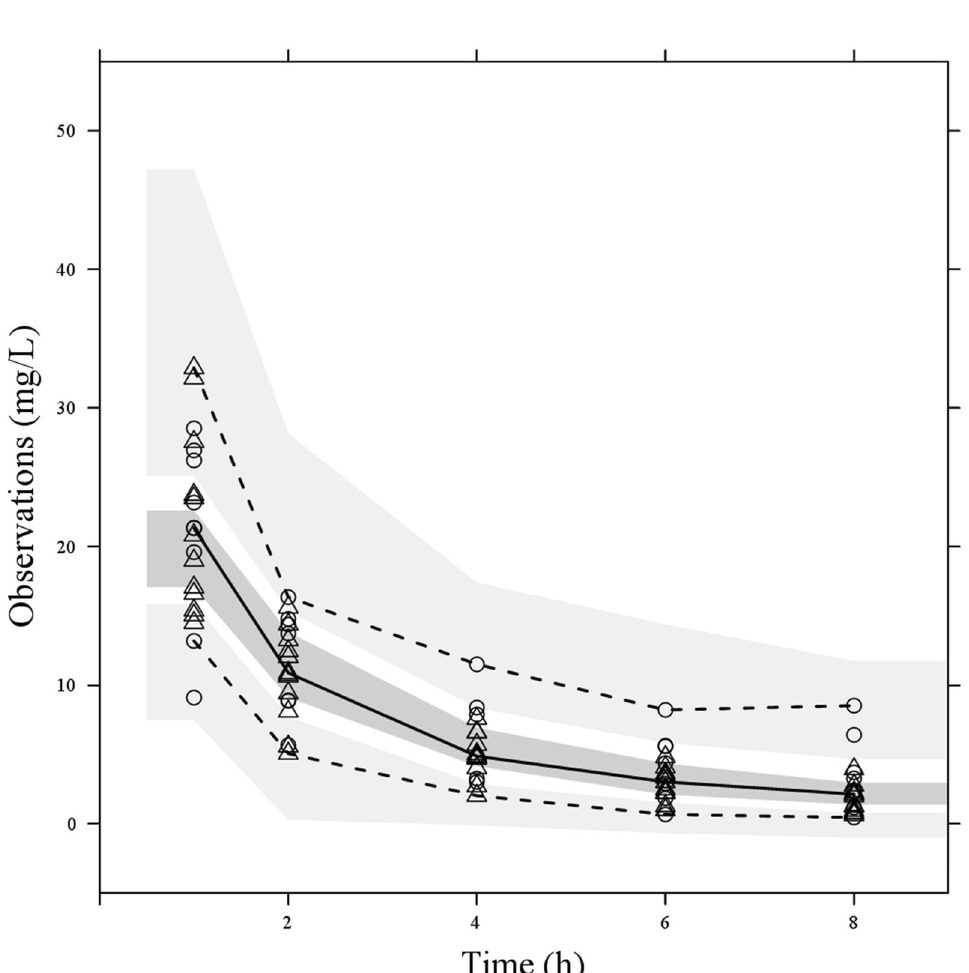
Figure 5. Visual predictive check for the final model. The open circles show observations for CRRT group and the open triangles for non-CRRT group. The solid line shows the fiftieth percentile of the observations, and the dashed lines show the fifth and ninety-fifth percentiles of the observations. The shaded areas show the 95% confidence intervals of the fifth, fiftieth, and ninety-fifth percentiles of the